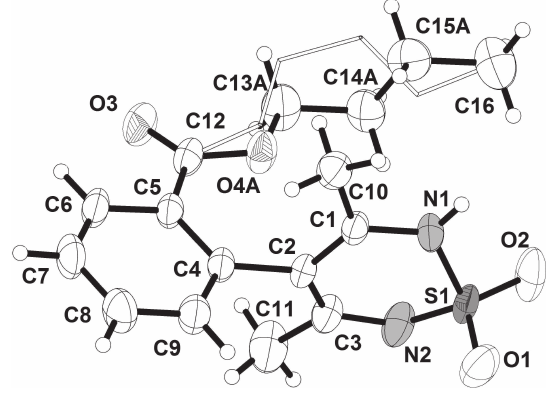
Table 2: Fractional atomic coordinates and isotropic or equivalent isotropic displacement parameters (Å 2